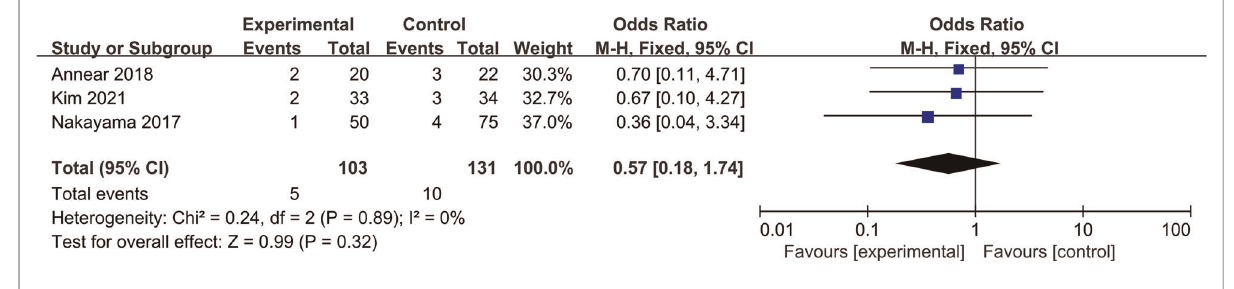
FIGURE 15 Forest pot for re-injury rate.